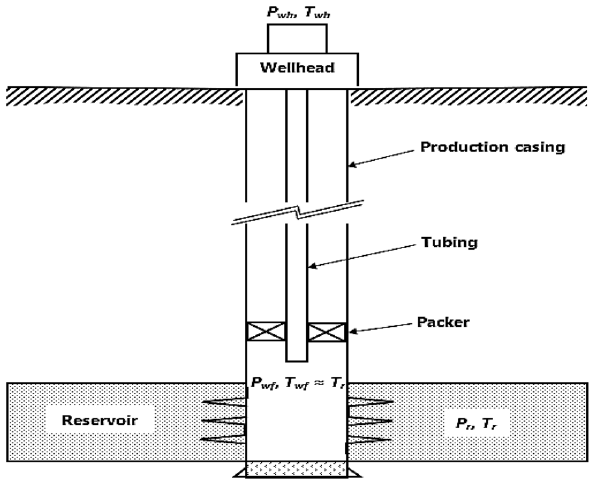
Fig. 3 Pressures and temperatures at key nodes in a producing